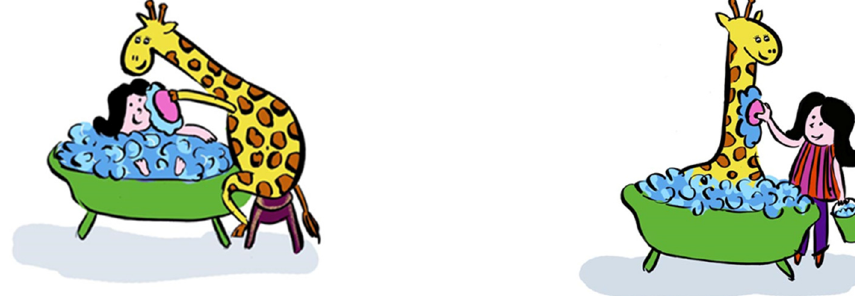
Figure A2. An example of a picture used in the picture selection task. A.1.3. Comprehension of Written Object Relatives: Paraphrasing of Object Relatives with Center Embedding In this task (BAFLA ZIKRIA [99,100]) the participants were asked to read 20 sentences aloud and then explain them in their own words. Half (10) of the sentences were center-embedded relative clauses, in which the main verbs were heterophonic-homographs of nouns. The other 10 sentences were simple control sentences with the same homographic verbs and the same length. The participants were requested to read each sentence aloud and to paraphrase it as accurately as possible. To reduce demands on memory, each written sentence remained in front of the participants until they finished reading and paraphrasing it (for details about this task see also [46]). We used the paraphrasing of the object relative clauses in this task as a measure of the participant’s syntactic abilities.